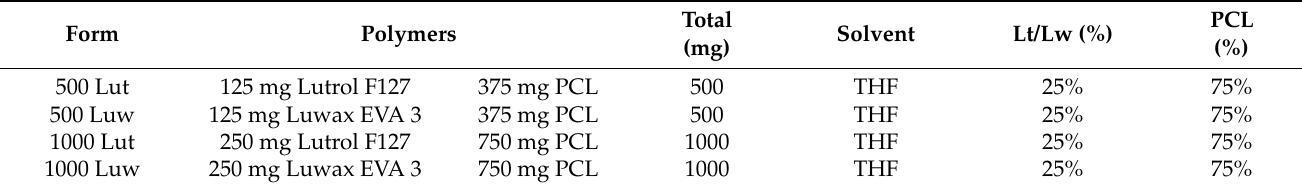
Table 3. Coating films composition (THF: tetrahydrofuran; Lt: Lutrol F127; Lw: Luwax EVA 3). Form